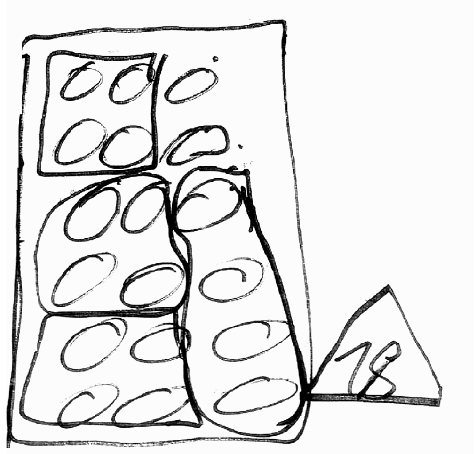
Figura 7. As partes e o resto para 18(cid:247)4.